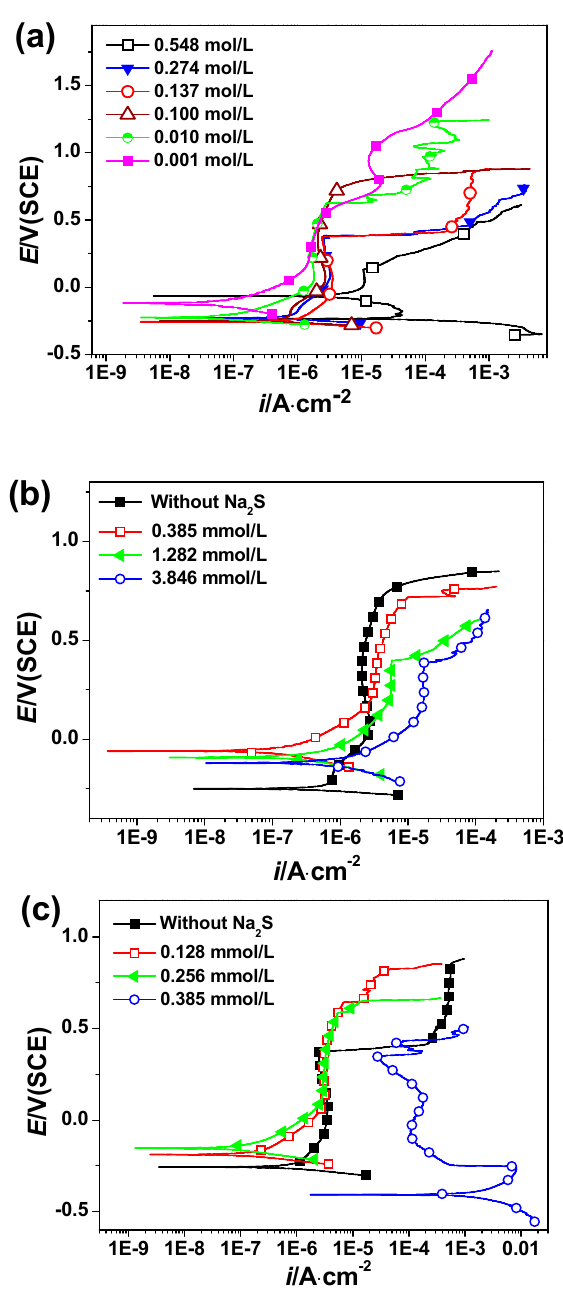
Figure 1. Polarization curves of 2205 DSS in ( a ) HCl solutions, ( b ) 0.1 mol/L HCl + Na 2 S solutions and ( c ) 0.137 mol/L HCl + Na 2 S solutions at 90 °C .